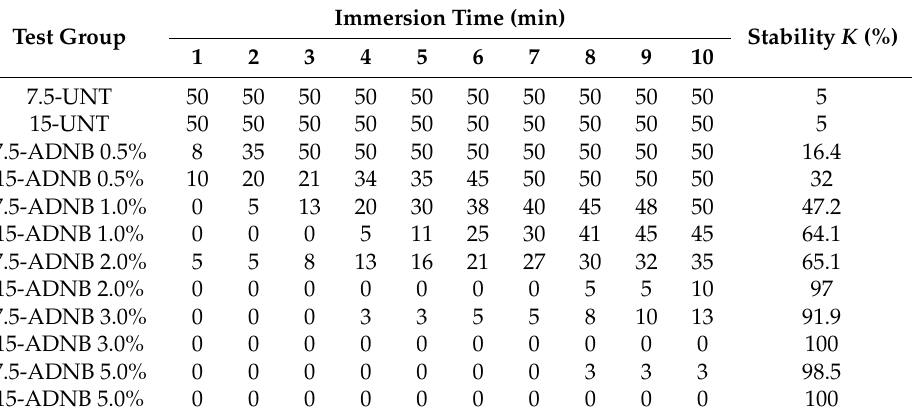
Table 3. Static water stability of the different